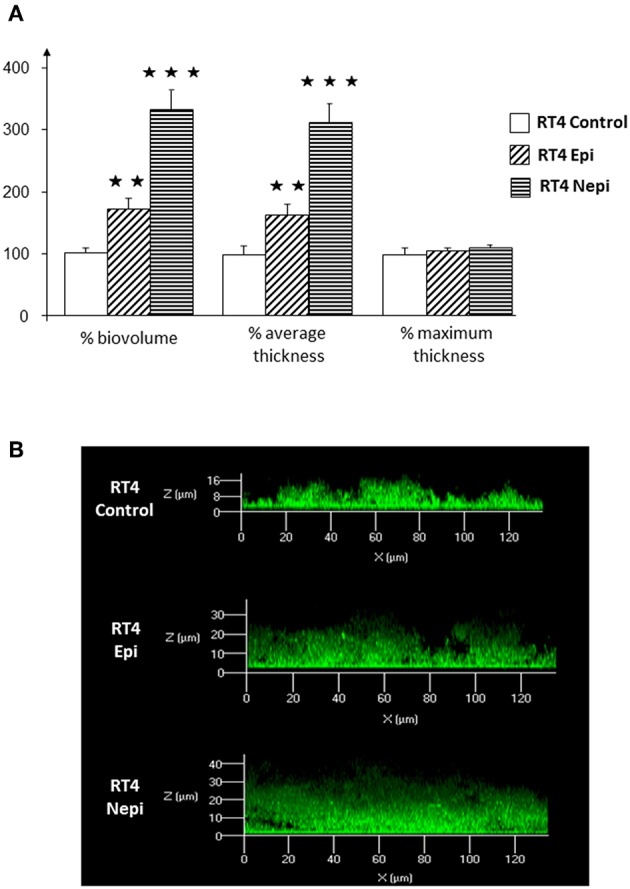
Effect of epinephrine and norepinephrine on biofilm formation by the RT4 acneic strain of Cutibacterium acnes on a glass support measured by confocal laser scanning microscopy. (A) Biovolume, average thickness, and maximum thickness of the biofilms after exposure to epinephrine (Epi) or norepinephrine (Nepi) calculated using Zen® 2009 software. (B) Representative views of X/Z sections of the biofilms formed in the presence or absence of epinephrine (Epi) or norepinephrine (Nepi). (⋆⋆p < 0.01, ⋆⋆⋆p < 0.001).